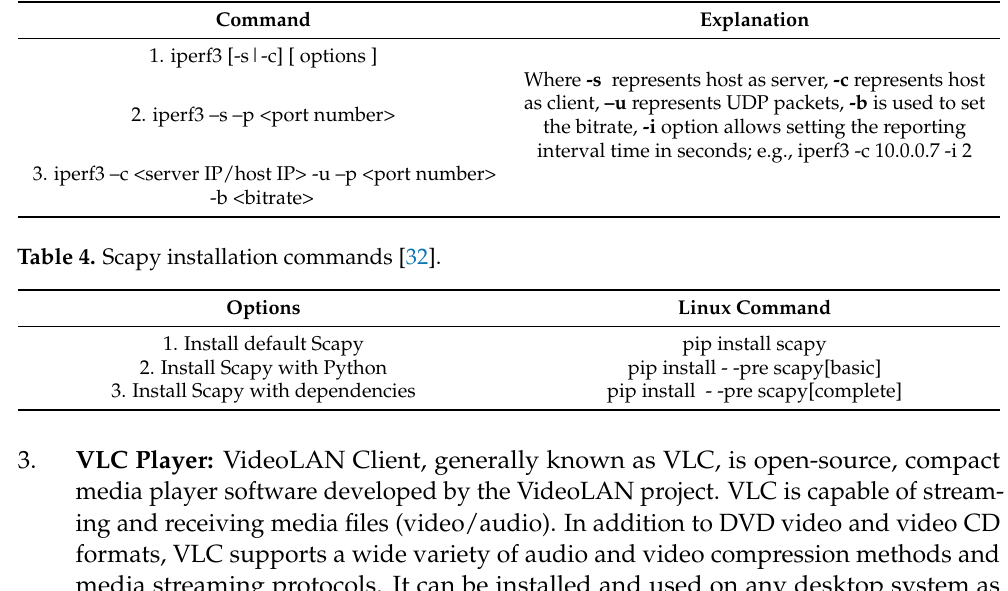
Table 3. Iperf3 commands to generate UDP/TCP data packets [29].